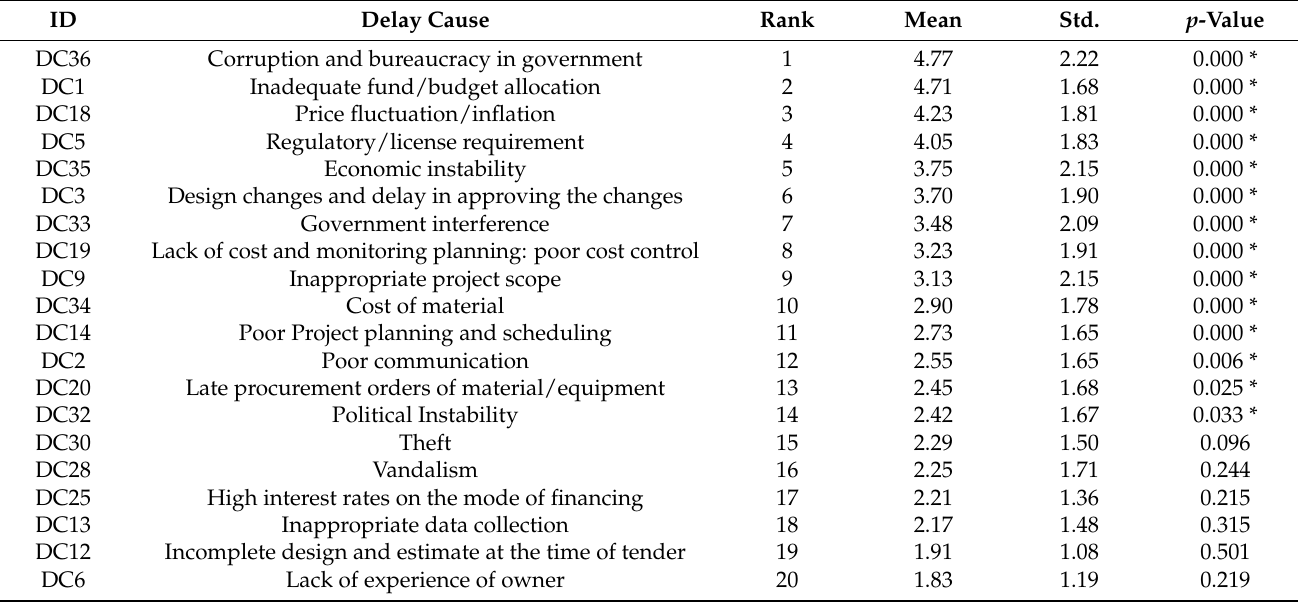
Table 4. Rank and mean score of delay